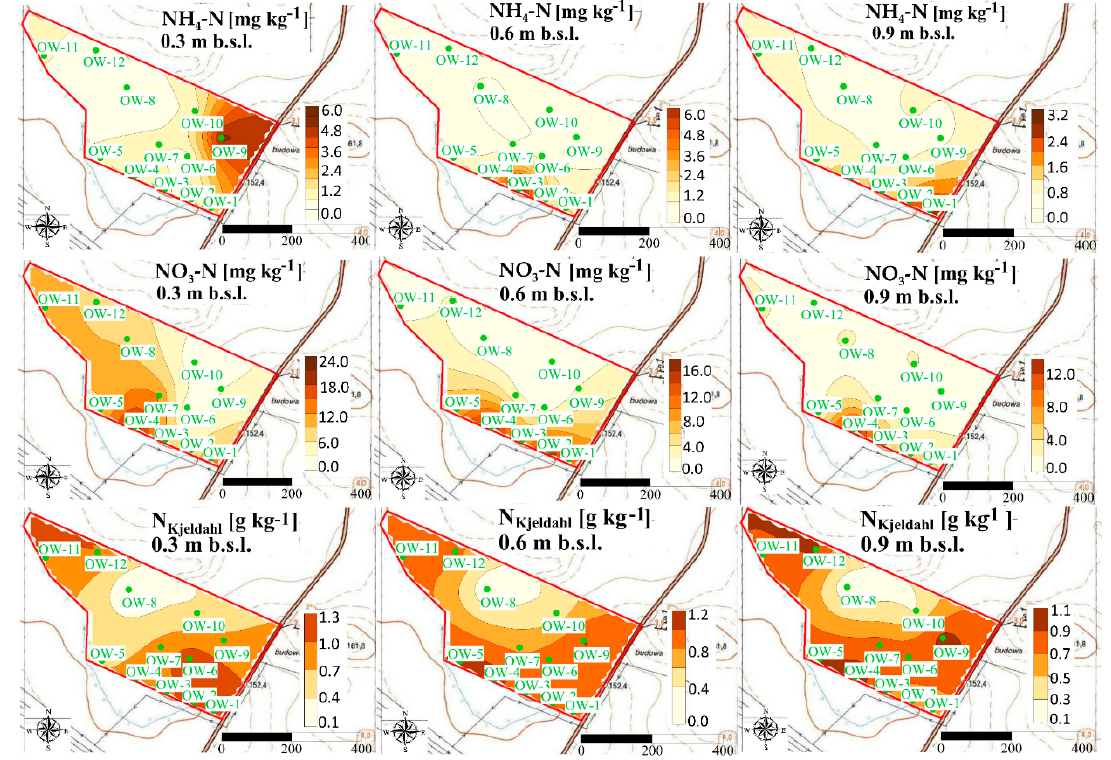
Figure 8. Spatial distribution of ammonium, nitrate, and N Kjeldahl in soil at the A experimental site after UNI fertilization.